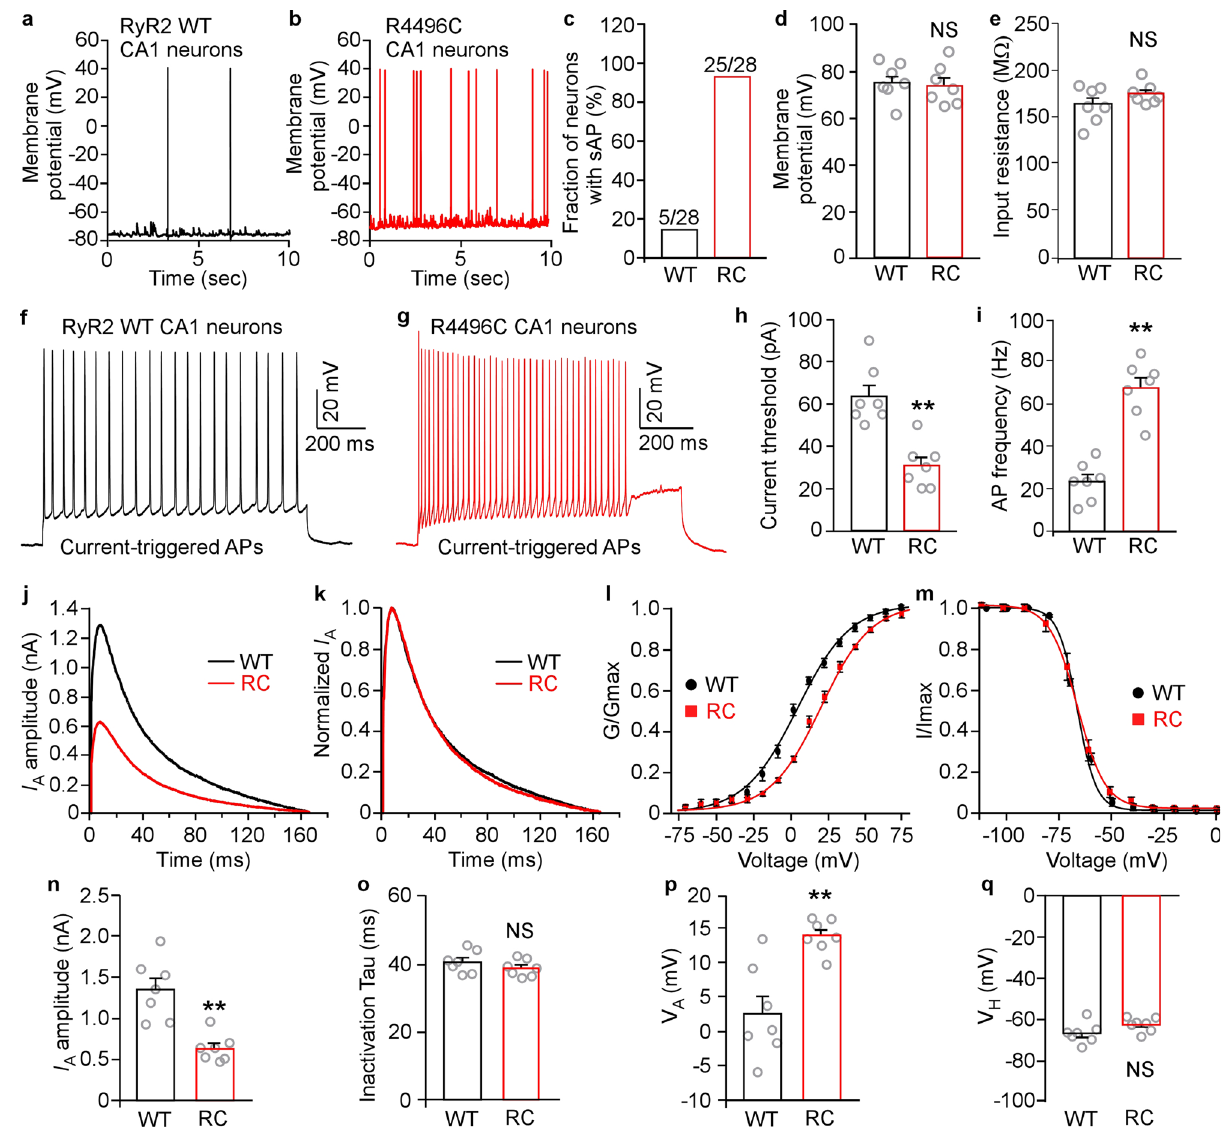
Fig. 6 CPVT RyR2 mutation R4496C + / − enhances spontaneous and triggered action potential fi ring and decreases the A-type K + current ( I A ) in hippocampal CA1 neurons. Hippocampal brain slices were prepared from RyR2 WT and R4496C + / − mutant mice (3 – 4 months old). Action potential fi ring was recorded using whole-cell patch-clamp technique. Representative traces of membrane potential recordings showing spontaneous action potential (sAP) fi ring in RyR2 WT ( a ) and R4496C + / − mutant ( b ) mouse hippocampal CA1 neurons. c Fraction (%) of RyR2 WT and R4496C + / − (RC) CA1 neurons displaying sAP fi ring. Note that the RyR2 mutation R4496C + / − markedly increases the percentage of CA1 neurons showing sAP fi ring. d Resting membrane potentials of CA1 neurons from RyR2 WT and R4496C + / − mutant mice (3 – 4 months old). e Input resistance of CA1 neurons from RyR2 WT and R4496C + / − mutant mice (3 – 4 months old). Representative traces of membrane potential recordings showing AP fi ring after current injection of 150 pA into the RyR2 WT ( f ) and R4496C + / − mutant ( g ) hippocampal CA1 neurons. h Current threshold (pA) was de fi ned as the minimum current injection required to trigger the fi rst AP fi ring in WT or R4496C + / − (RC) mouse hippocampal CA1 neurons. Note that the R4496C + / − mutation reduces the current threshold for triggering AP fi ring. i The frequency of current injection-triggered APs. Note that the R4496C + / − mutation increases the AP fi ring frequency in hippocampal CA1 neurons. Data shown are mean ± SEM ( n = 28 neurons in slices from 7 WT brains, and n = 28 neurons in slices from 7 R4496C + / − brains) (Mann – Whitney U test, * p < 0.05). j Representative traces of A-type K + current ( I A ) from 3 – 4 months old RyR2 WT and R4496C + / − (RC) CA1 neurons. k Normalized I A traces. l Steady-state activation curves of I A . m Steady-state inactivation curves of I A . n I A amplitude in 3 – 4 months old RyR2 WT (7 mice, 28 neurons) and R4496C + / − (RC) (7 mice, 28 neurons) CA1 neurons. o I A inactivation kinetics (Tau) from the same number of neurons as in n . p The midpoints of voltage-dependent activation of I A ( V A ) for RyR2 WT (7 mice, 28 neurons) and R4496C + / − (RC) (7 mice, 28 neurons) CA1 neurons. q The midpoints of voltage-dependent inactivation of I A ( V H ) for RyR2 WT (7 mice, 28 neurons) and R4496C + / − (RC) (7 mice, 28 neurons) CA1 neurons. (Mann – Whitney U test, ** p < 0.05; NS not signi fi cant).